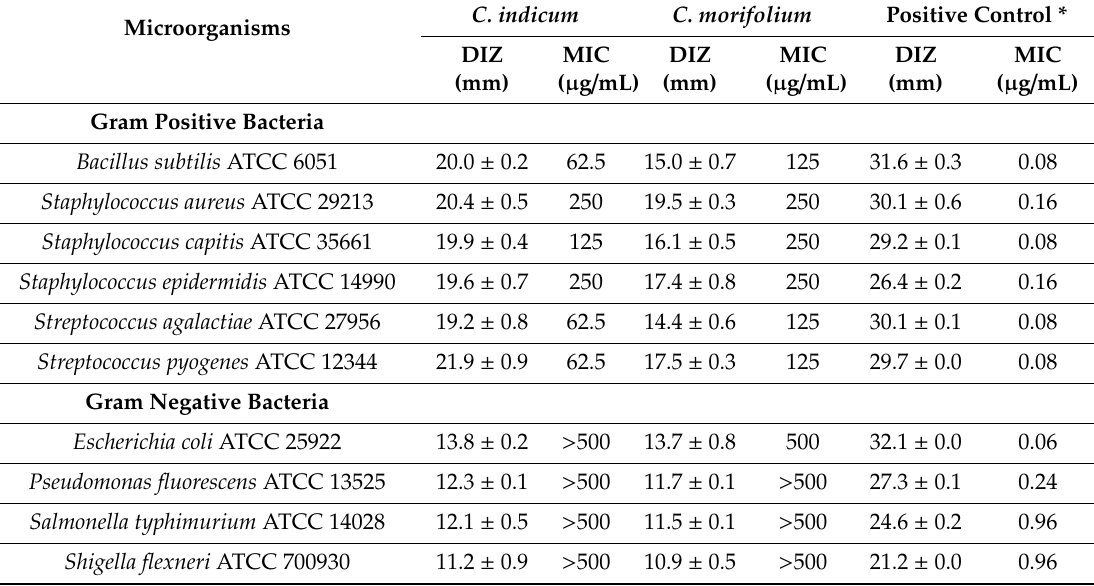
Figure 5. Antiviral activity of the essential oils obtained from C. indicum and C. morifolium flower heads versus vesicular stomatitis virus (VSV) ( A ), hepatitis A (HAV) ( B ) and herpes simplex type-1 (HSV-1) ( C ) using acyclovir as a standard antiviral drug. The means with di ff erent stars are significantly di ff erent ( p < 0.05). Table 2. Minimum inhibitory concentrations (MIC) in ( µ g / mL) and mean diameter of inhibition zones (DIZ) in (mm) of C. indicum and C. morifolium essential oils against di ff erent pathogens determined by microdilution and agar di ff usion